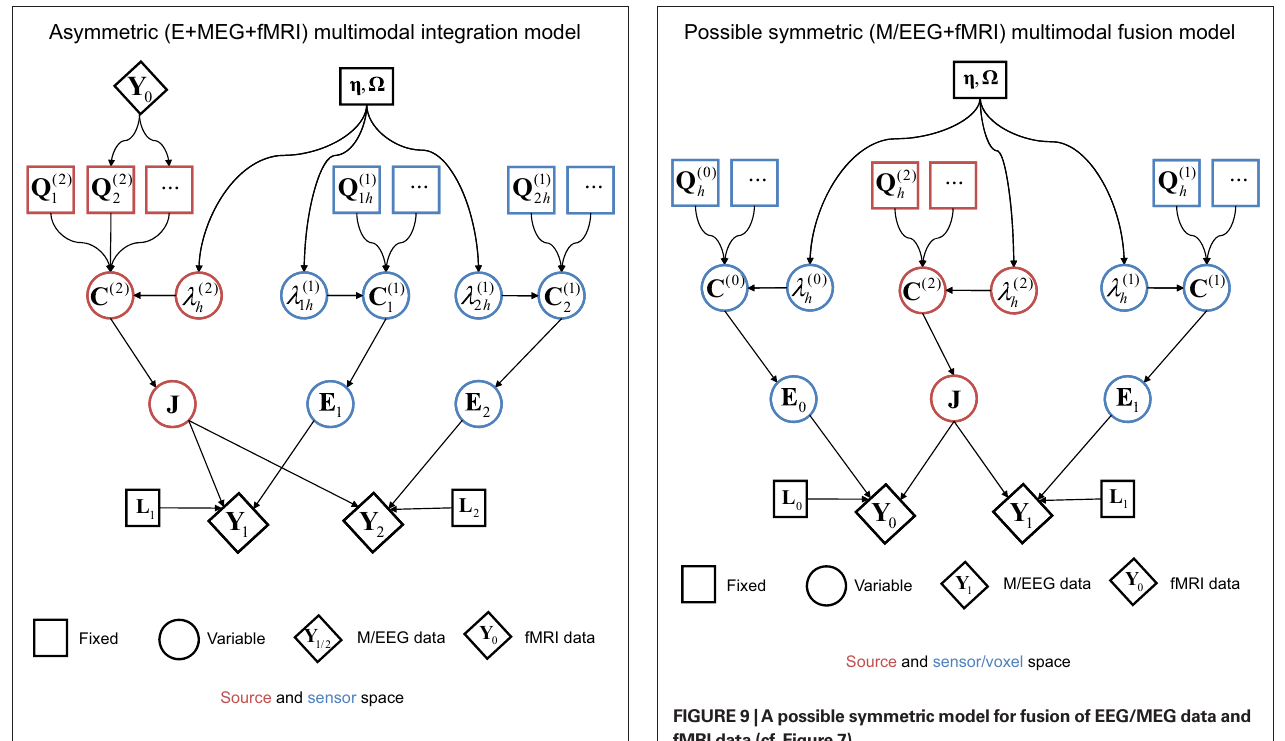
Figure 7 | The extension of the generative model in Figure 4 to the addition of fMri priors (Y 0